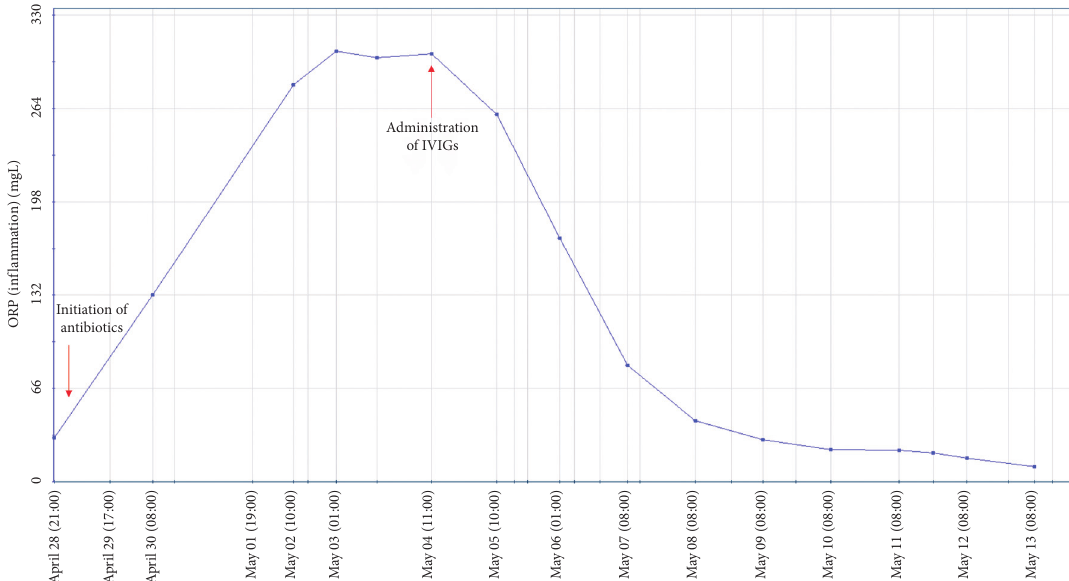
Figure 1: Course of C-reactive protein in Case 2 in the year